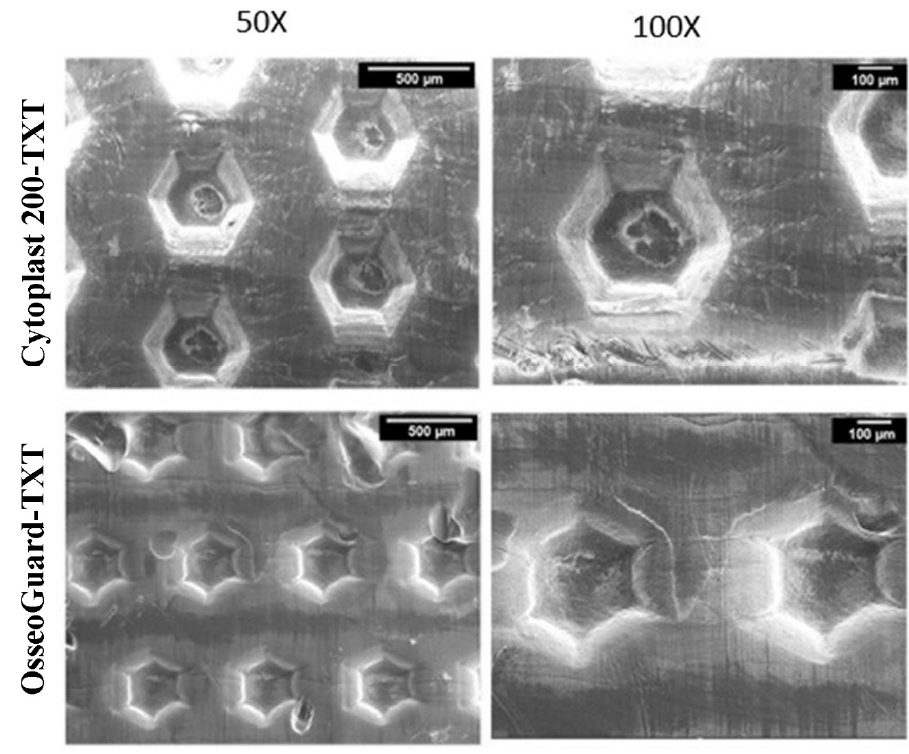
Figure 2. SEM images of the textured PTFE membranes.